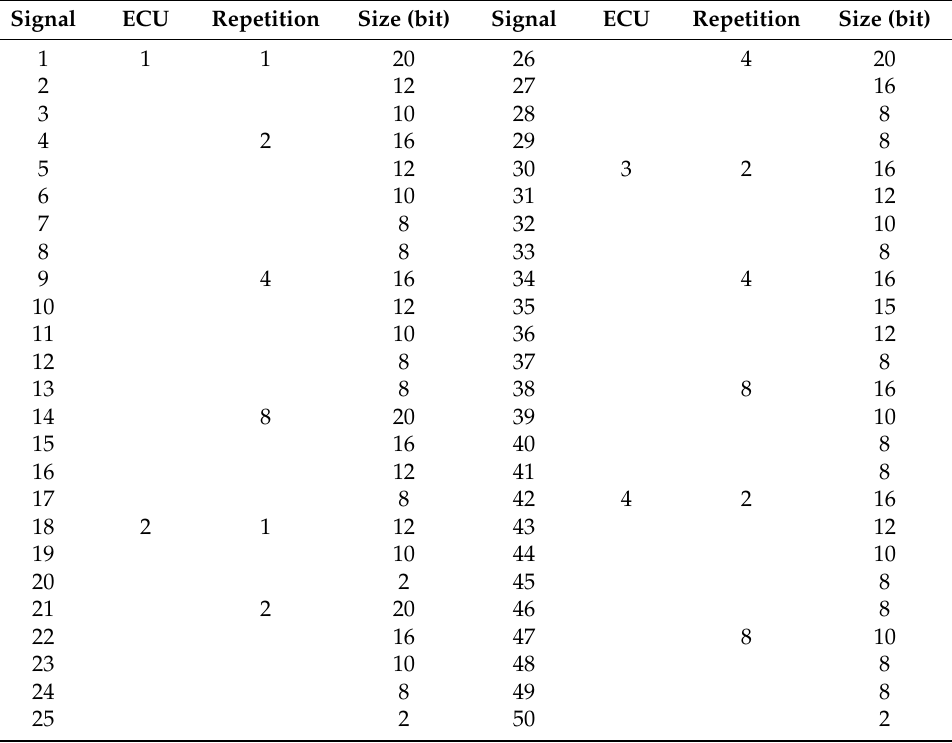
Table 5. FlexRay network signal